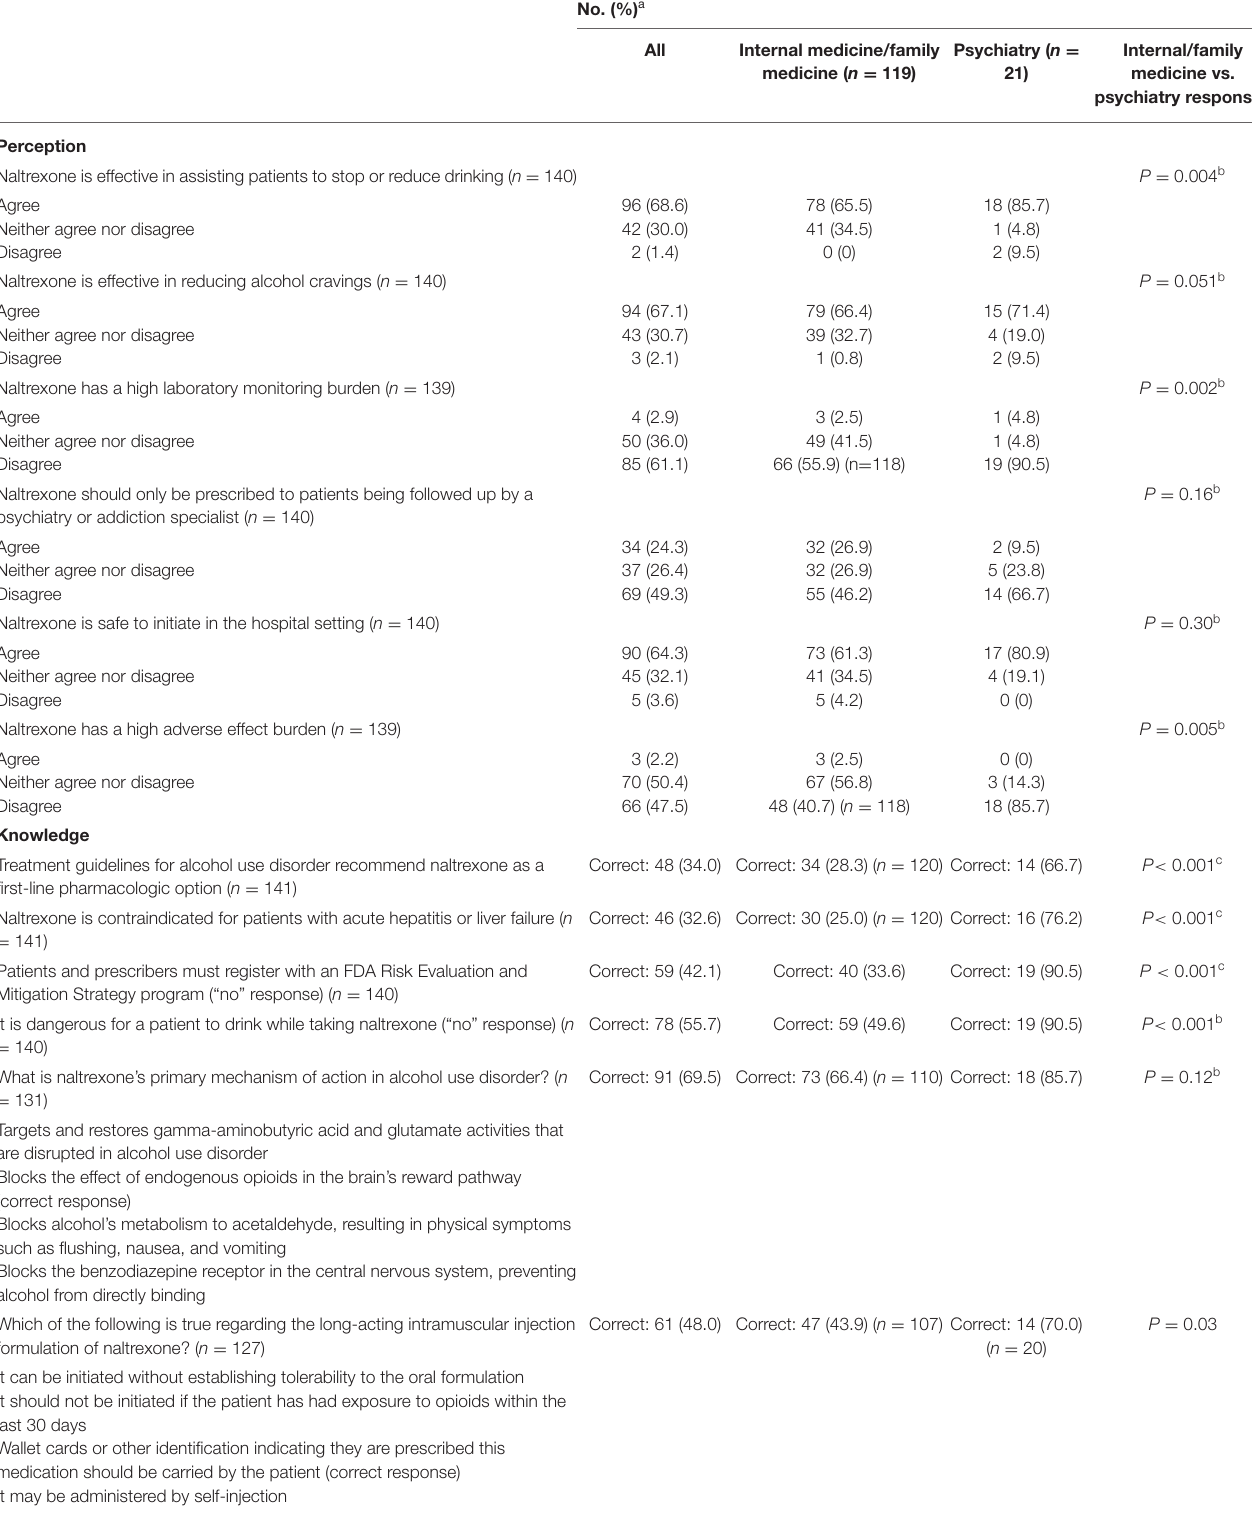
TABLE 3 | Perception and knowledge